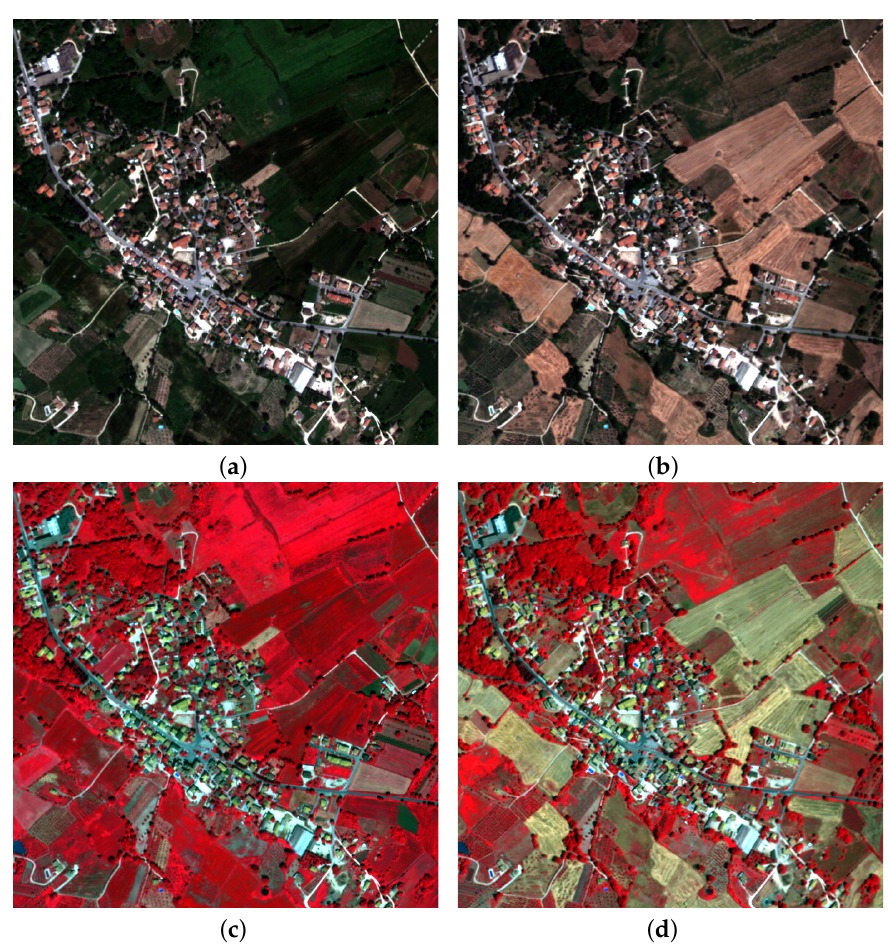
Figure 3. The 512 × 512 details of the original GeoEye-1 MS images acquired on ( a , c ) 27 May 2010 and ( b , d ) 13 July 2010. ( a , b ) 3-2-1 true color display; ( c , d ) 4-3-2 false color composite